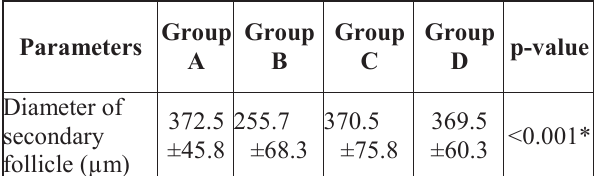
Table-3: Comparison of diameter of secondary follicle among groups based on one way ANOVA.